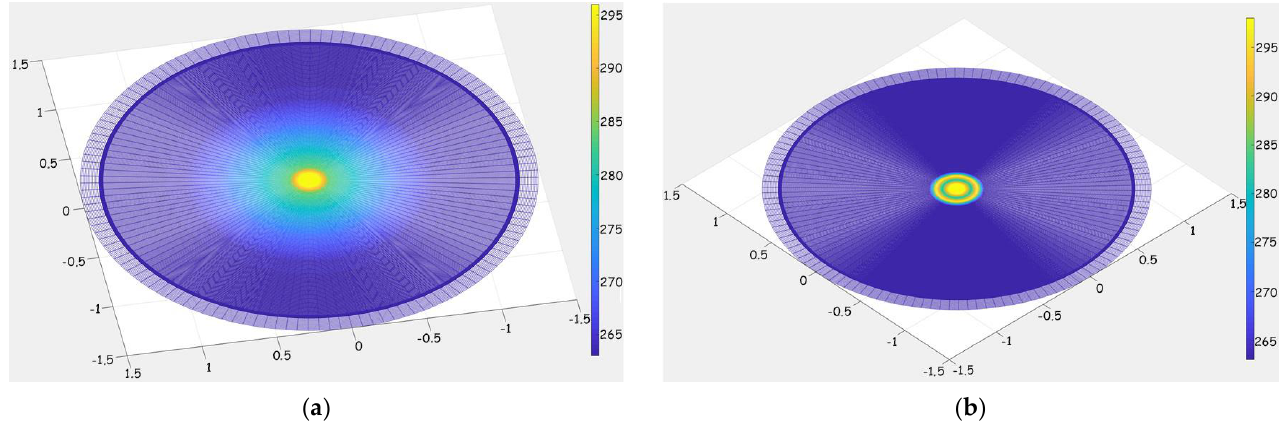
Figure 4. Temperature zone model: ( a ) — 1 min after fluid injection; ( b ) — 4 h after the injection of the process fluid